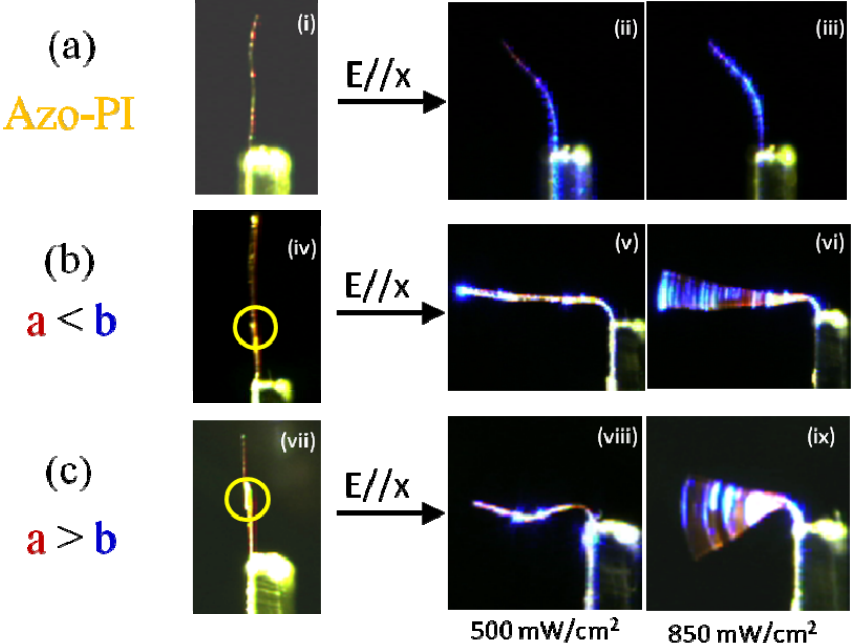
Figure 4. Photomechanical response of a azo-PI and azo-PI composite cantilevers composed of a MD-azo-LCN base (“a”) and the glassy azo-PI material (azo-PI) (“b”) observed upon irradiation to 500 and 850 mW/cm 2 . (a) Azo-PI monolithic cantilever, (b) a < b, and (c) a >